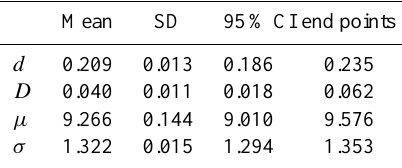
Table 7. Posterior summary statistics for CET index for the long- memory parameter d , seasonal long-memory parameter D , mean µ , and noise variance σ .